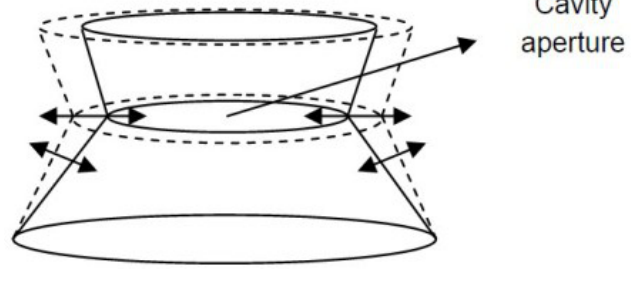
Figure 7. Cavity aperture radius variation.